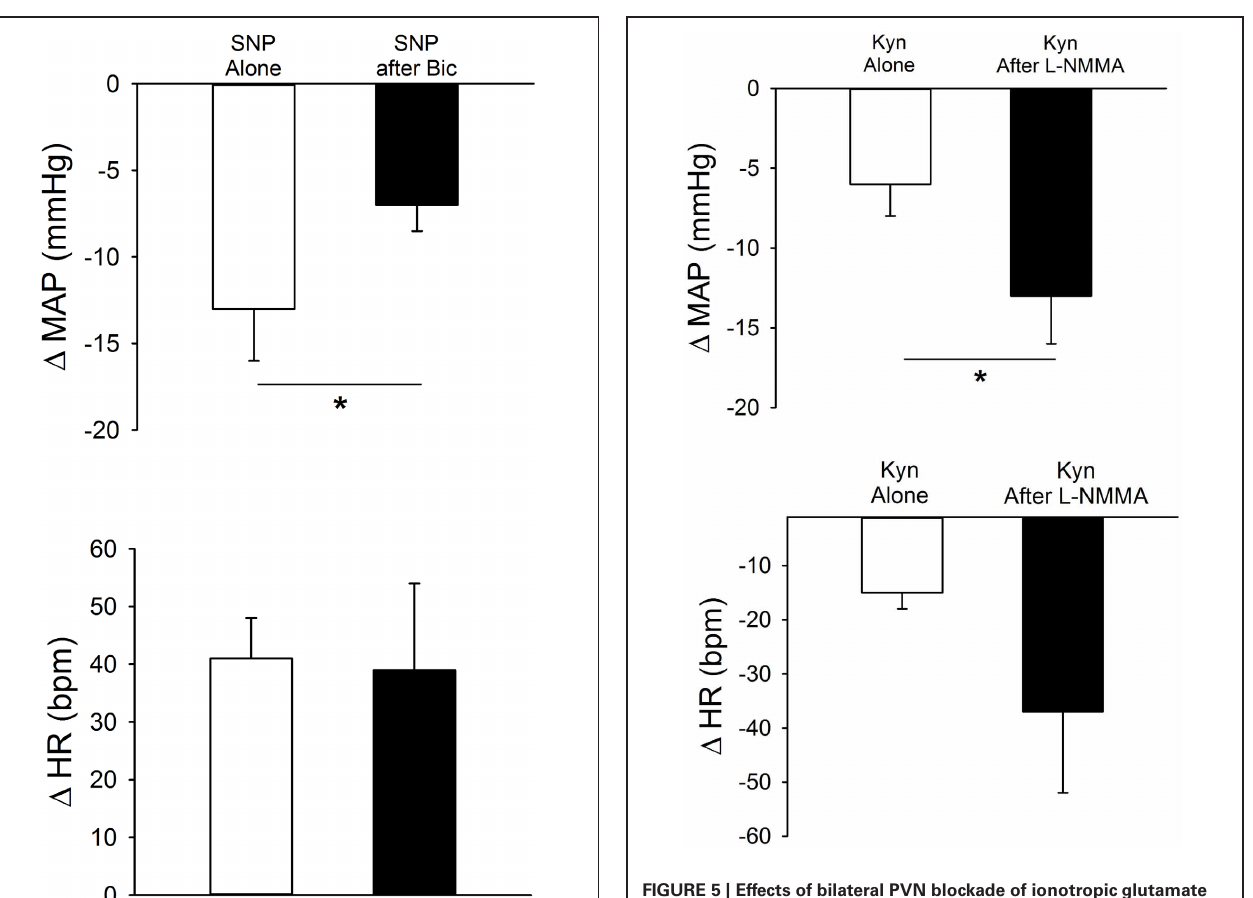
FIGURE 5 | Effects of bilateral PVN blockade of ionotropic glutamate receptors using kynurenic acid (Kyn, 40mM) alone (open bars) or after bilateral inhibition of NOS with L-NMMA (2mM, filled bars) in conscious rats ( n = 4). Bilateral microinjection of Kyn produced small but significant decreases in MAP and HR. Prior injection of L-NMMA significantly enhanced depressor responses to Kyn ( ∗ p ≤ 0 . 05) with no significant effect on HR